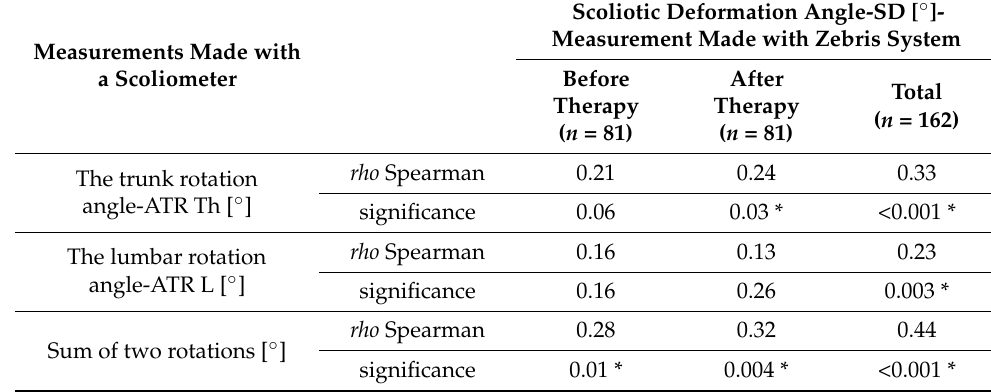
Scoliotic Deformation Angle-SD [ ◦ ]-